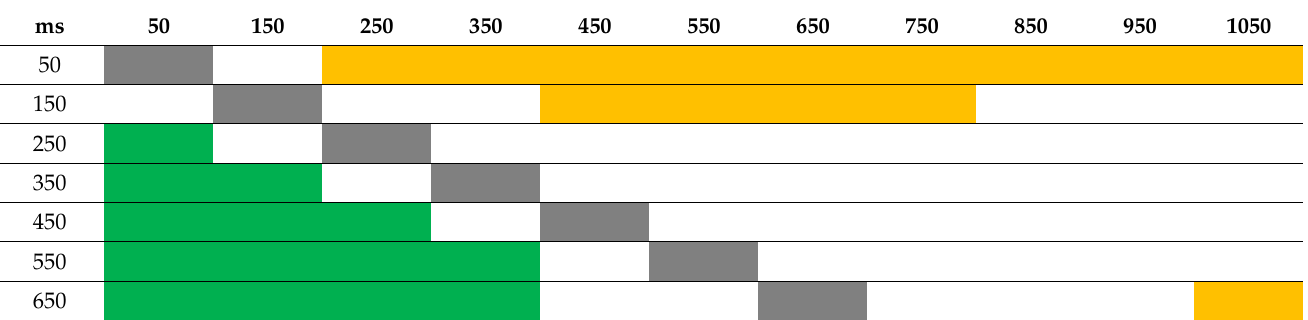
indicates diagonal